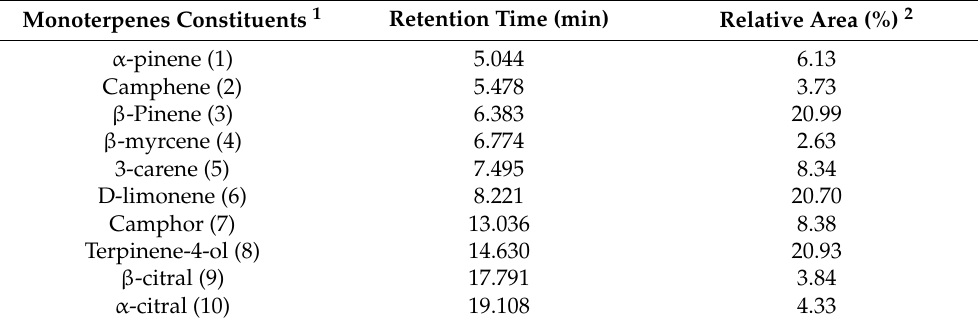
Table 2. The GC-MS retention times and the relative peak areas of the interested monoterpenoid constituents of mixed oil from the anti-cellulite herbal